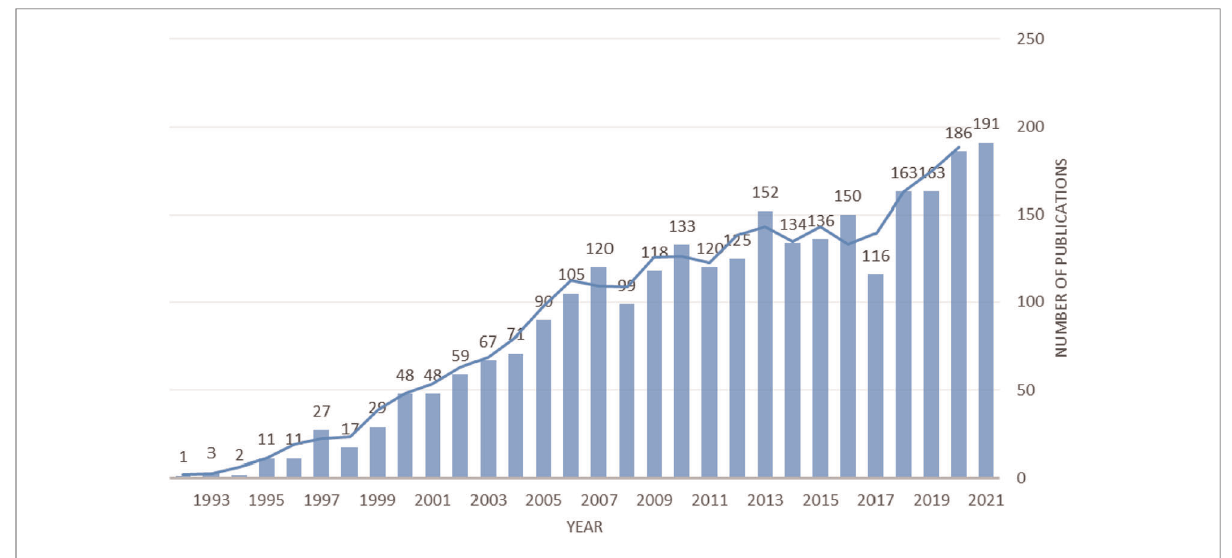
FIGURE 2 Chronological distribution of the publications from 1991 to 2021.